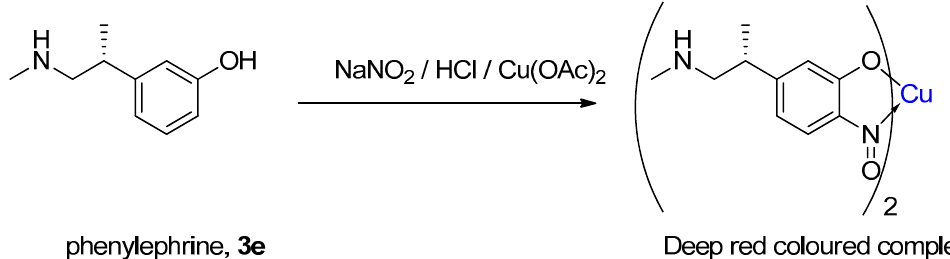
Figure 8. Dessouky’s colourimetry determination of phenylephrine, an example of copper-mediated nitrosation [25].